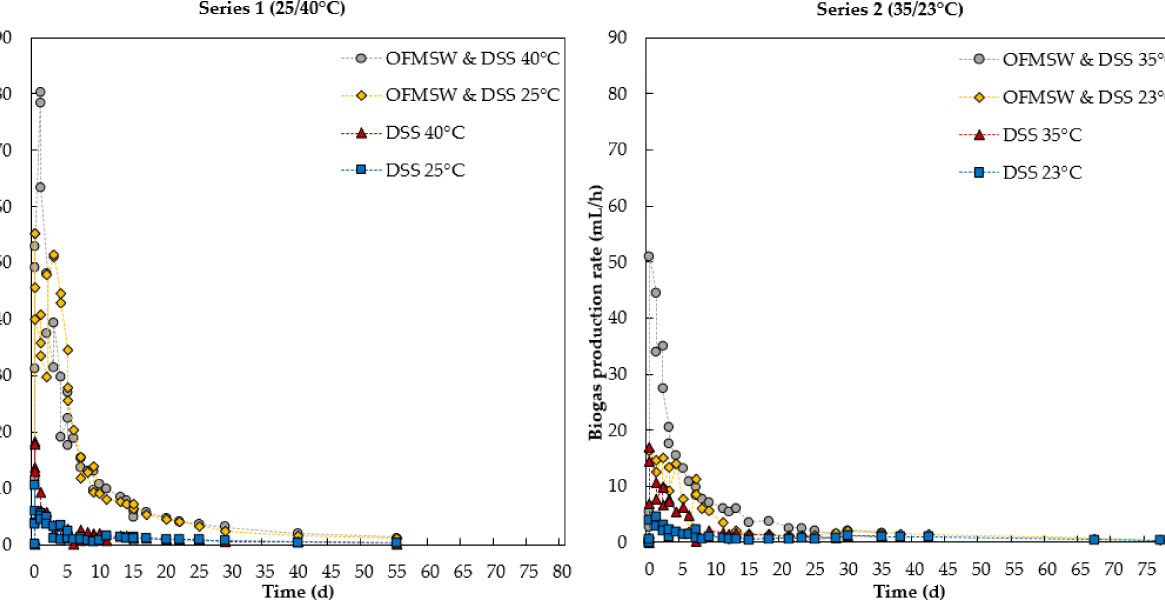
Figure 3. Biogas production rates for the mixtures of the organic fraction of municipal solid waste (OFMSW) and digested sewage sludge (DSS), and for DSS alone; mean values (n = 2 for DSS, n = 4 for OFMSW and DSS), gas volume at 1013 hPa, 0 ◦